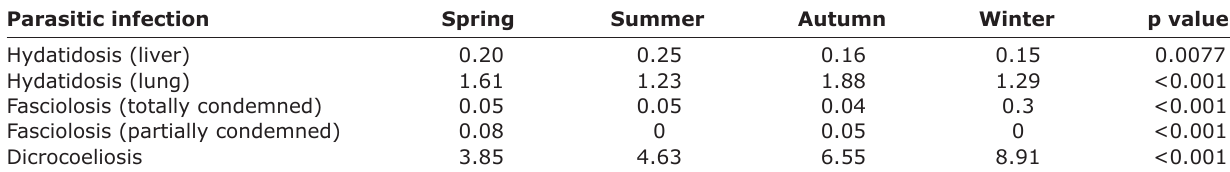
Table-2: Fasciolosis, dicrocoeliosis, and hydatidosis prevalence (%) and seasonal correlation (Chi-square